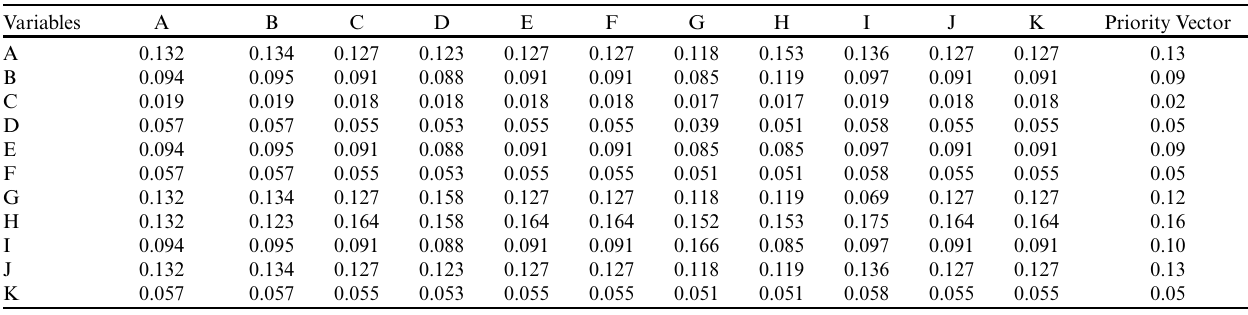
Table 6 . The synthesized matrix for regional authority for the rapid development scenario.